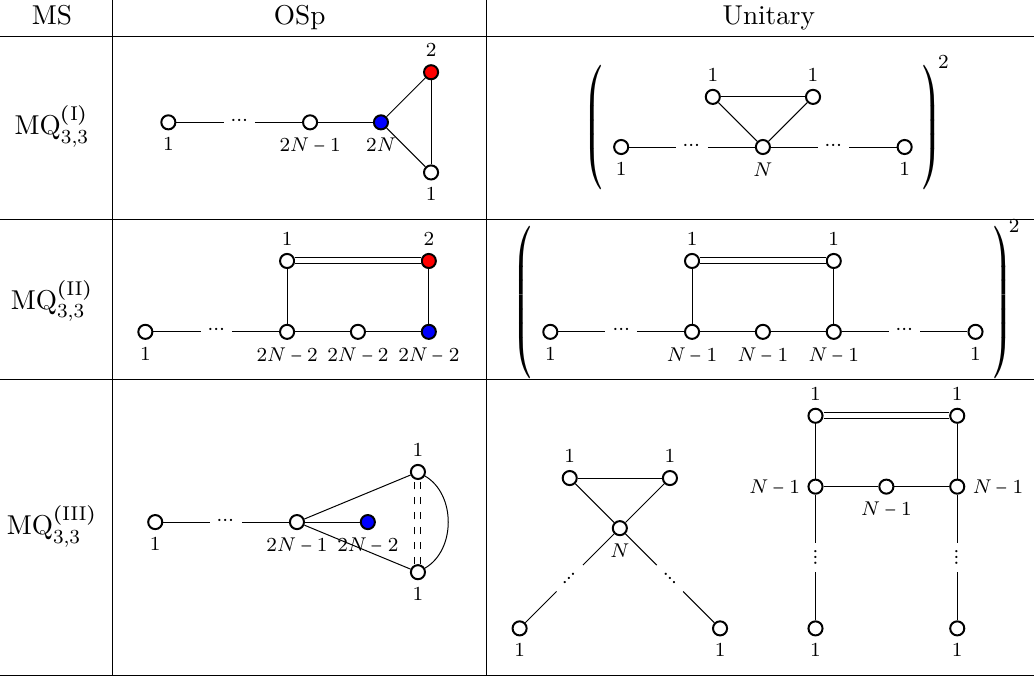
Table 3. Unitary and OSp magnetic quivers for the E 3 × E 3